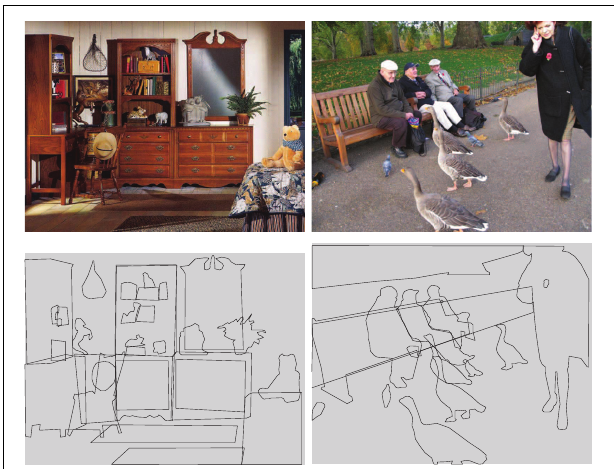
FIGURE 1 | Two example scenes with